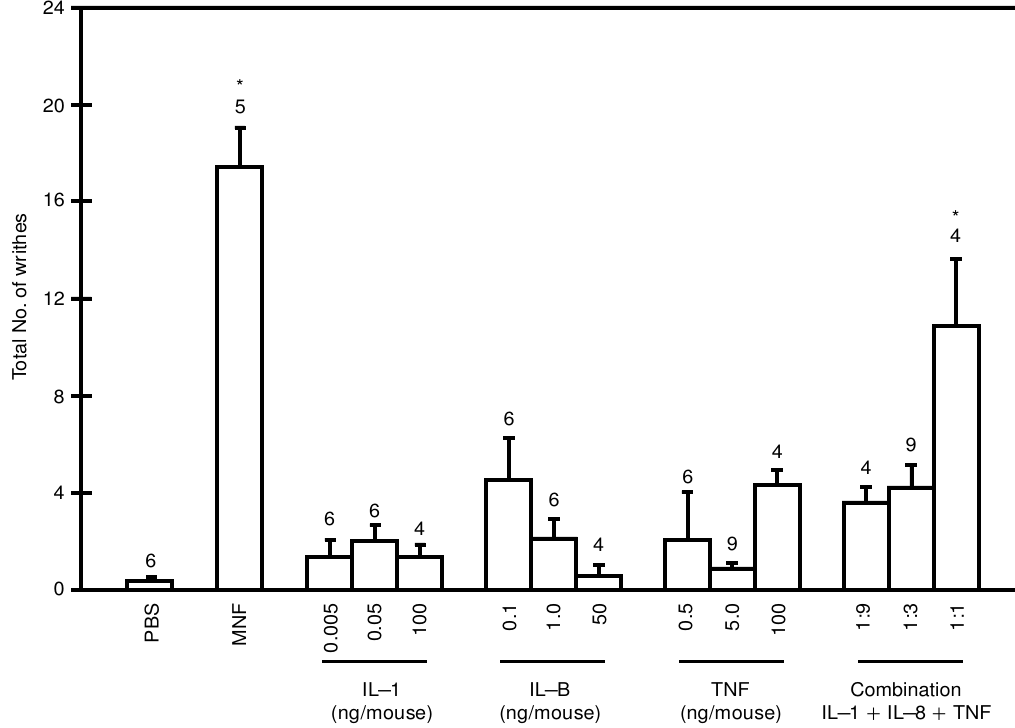
FIG. 5. The nociceptive effects of IL-1 b , IL-8, TNF- a or their mixture. The mice were injected with PBS, MNF, and indicated doses (ng / mouse) of IL-1, IL-8, and TNF- a or with three doses of the mixture of these three cytokines. The highest dose of the mixture was 100 ng / mouse IL-1 b + 50 ng / mouse IL-8 + 100 ng / mouse TNF- a (1:1); this was then used to prepare 1:3 or 1:9 dilutions. The number of writhes was determined in the interval between 14 and 34 min after the stimulus injection. The number at the top of each bar represents the number of mice in that group. The values are reported as means SEM. , Statistically signi® cant differences (P , 0 · 05) from the negative control (PBS) determined by ANOVA and Bonferroni’s test.